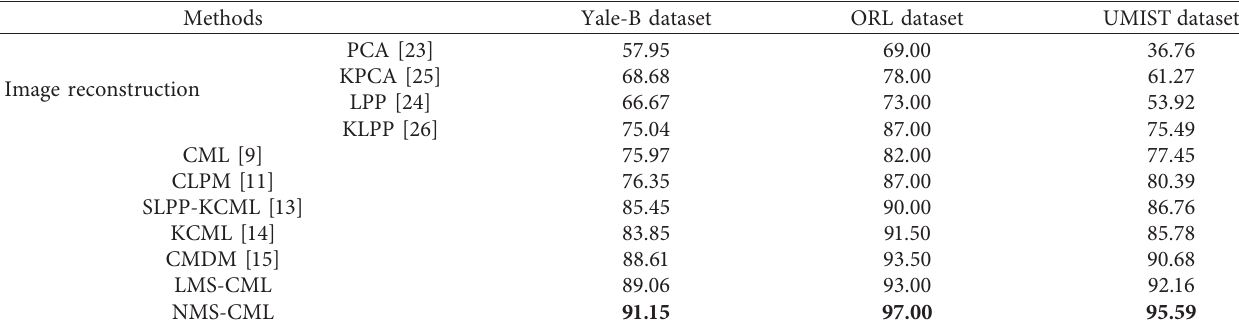
Table 3: Comparison of degraded face recognition results between our method and other methods. Methods